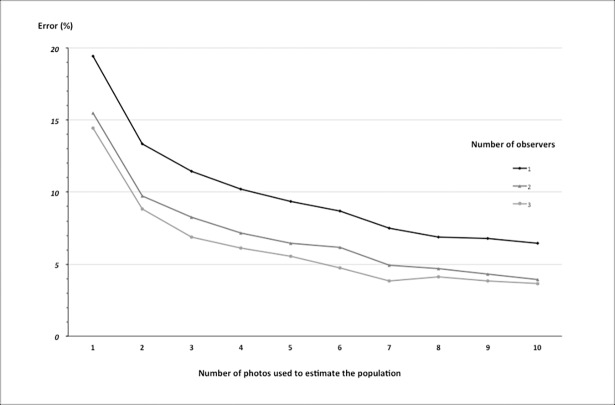
Error in the population size estimates in relation to numbers of photos and observers.